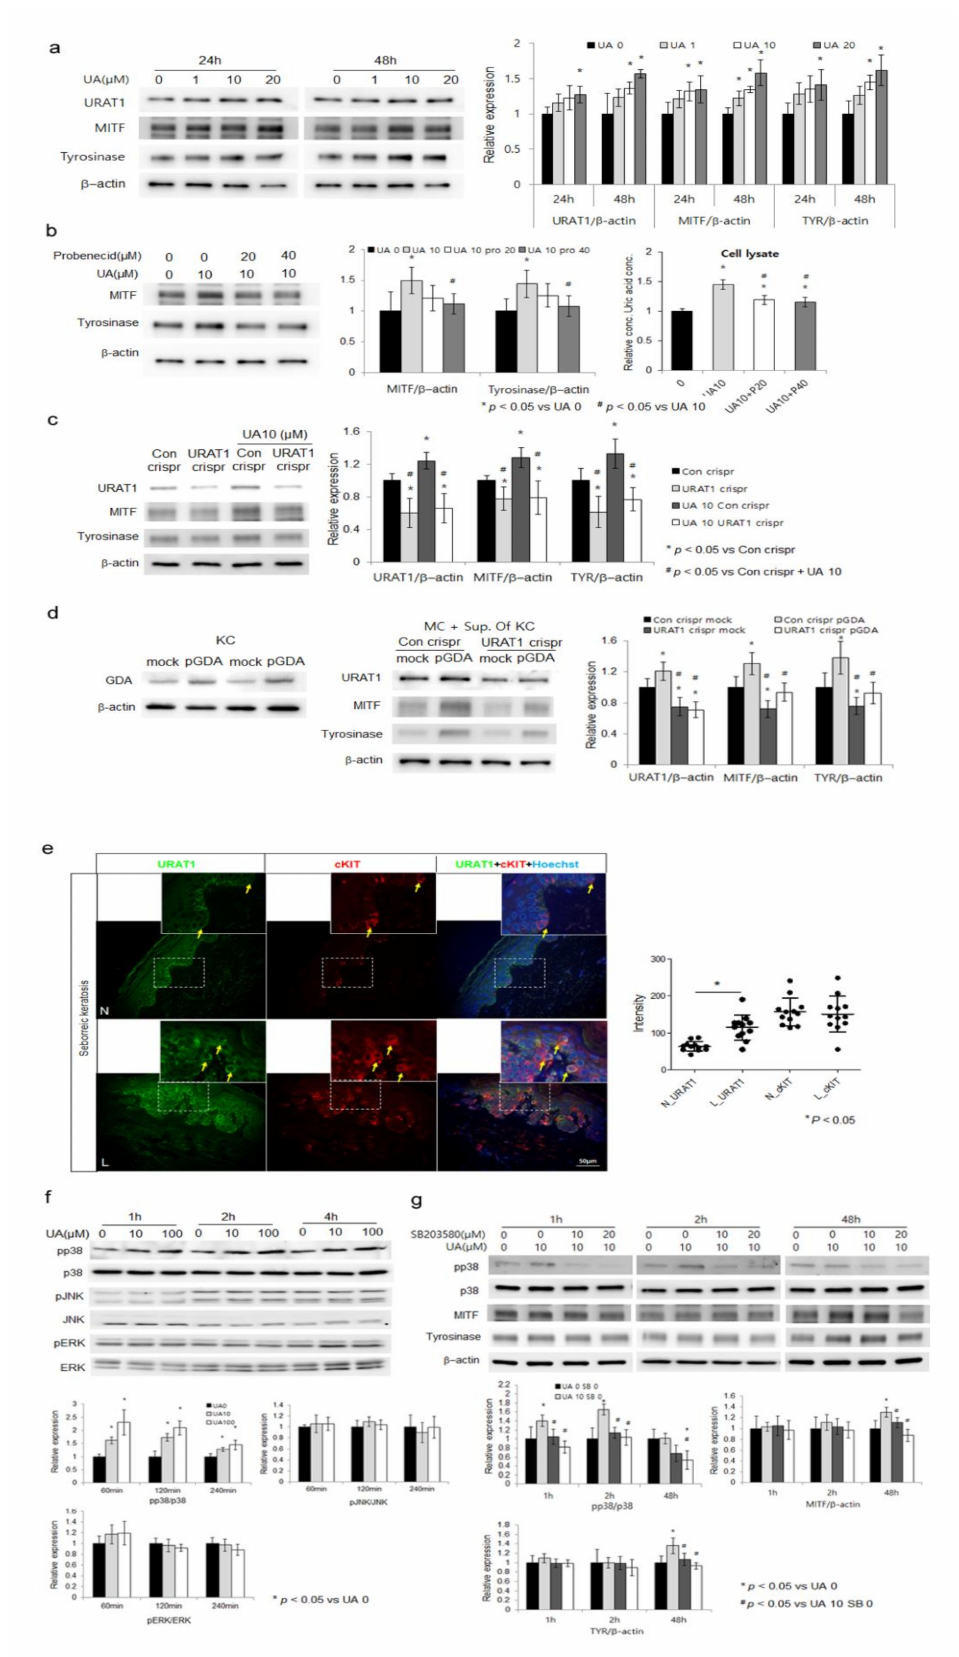
Figure 4. Uric acid uptake through URAT1 in melanocytes, stimulating melanogenesis via p38 MAPK. ( a ) Western blot analysis for relative ratios of URAT1 , tyrosinase, and MITF proteins in normal melanocytes treated with